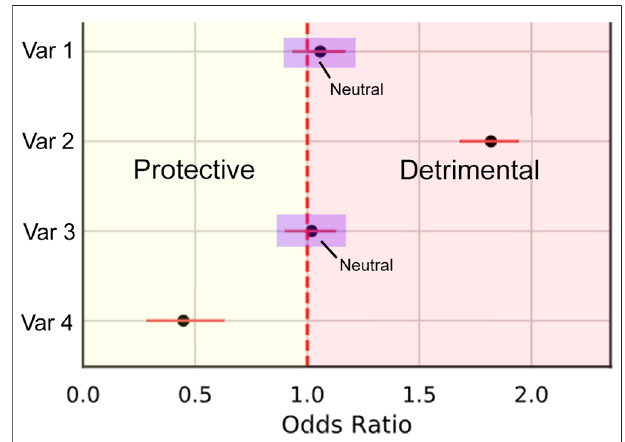
FIGURE 5 | Illustration demonstrating the three categories of odds ratio types . Protective effects are within the bounds of the yellow Section, Detrimental within red, and neutral where the con fi dence intervals intersect 1 (examples within the purple